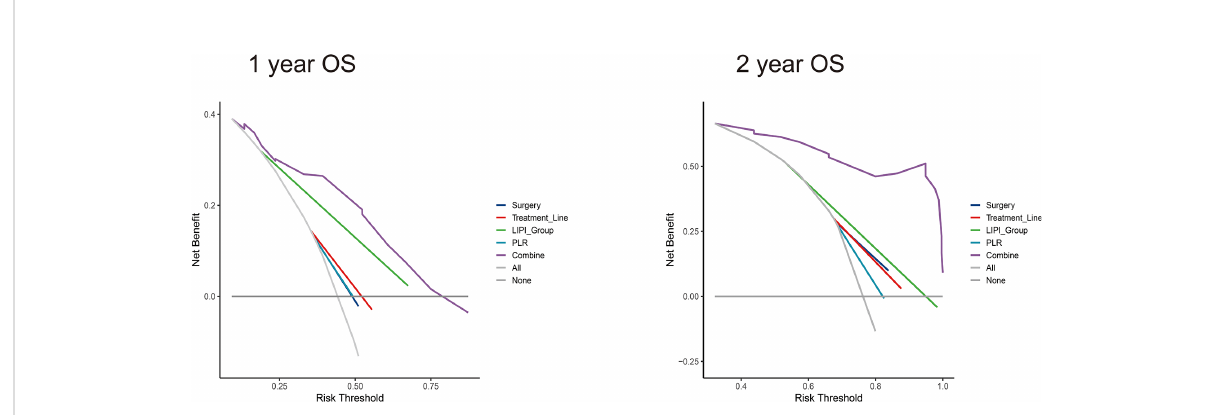
FIGURE 6 Decision curve analysis (DCA) of nomograms for the training set to predict 1- and 2-year survival. (Left) DCA for 1-year survival prediction in the nomogram; (right) DCA for 2-year survival prediction in the